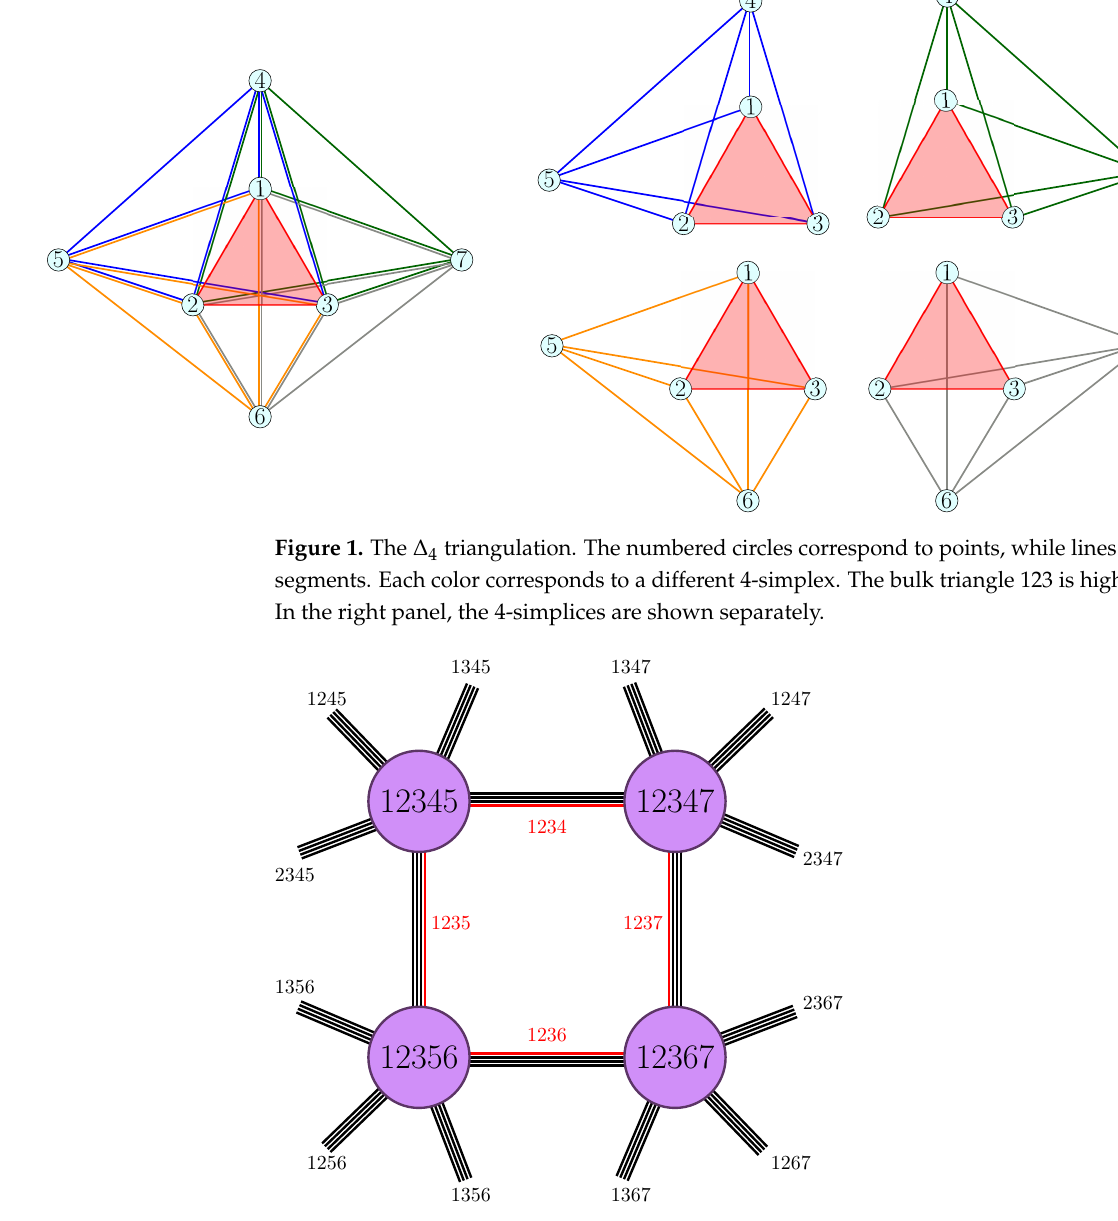
Figure 2. The 2-complex of the ∆ 4 triangulation. We named the vertices and the tetrahedra